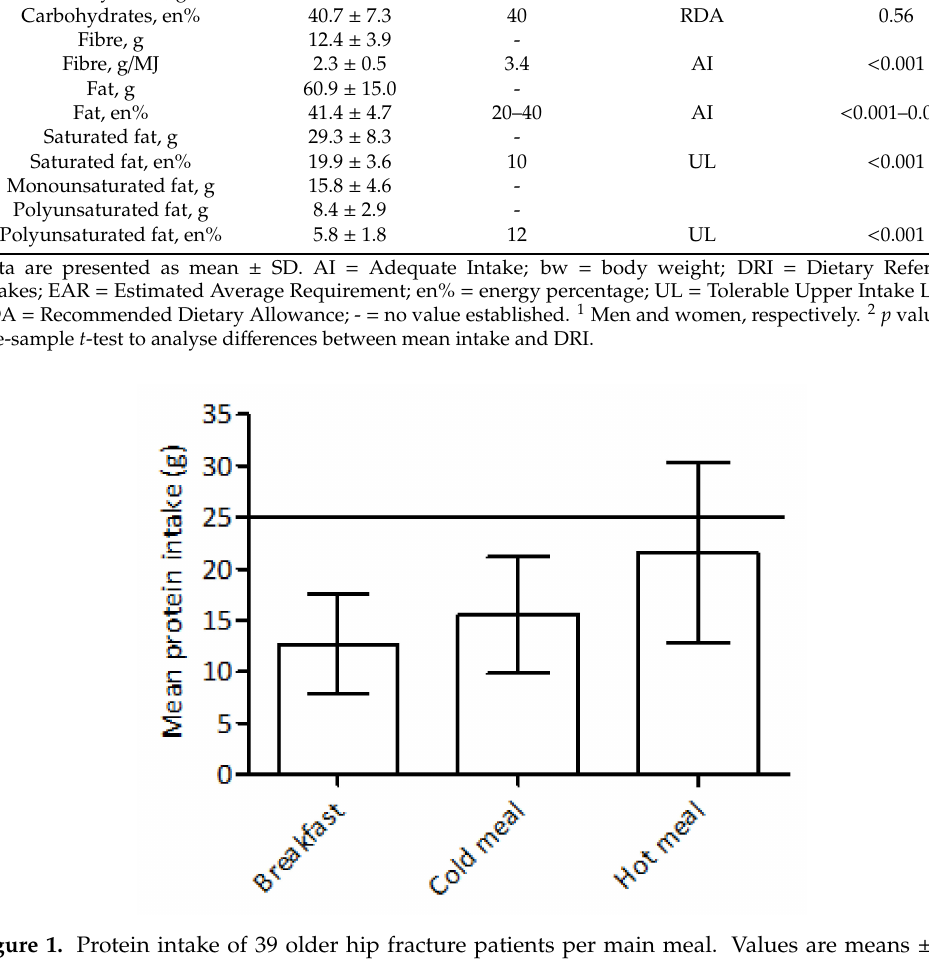
Figure 1. Protein intake of 39 older hip fracture patients per main meal. Values are means ± SD. Horizontal line represents the recommend lower limit of protein intake per main